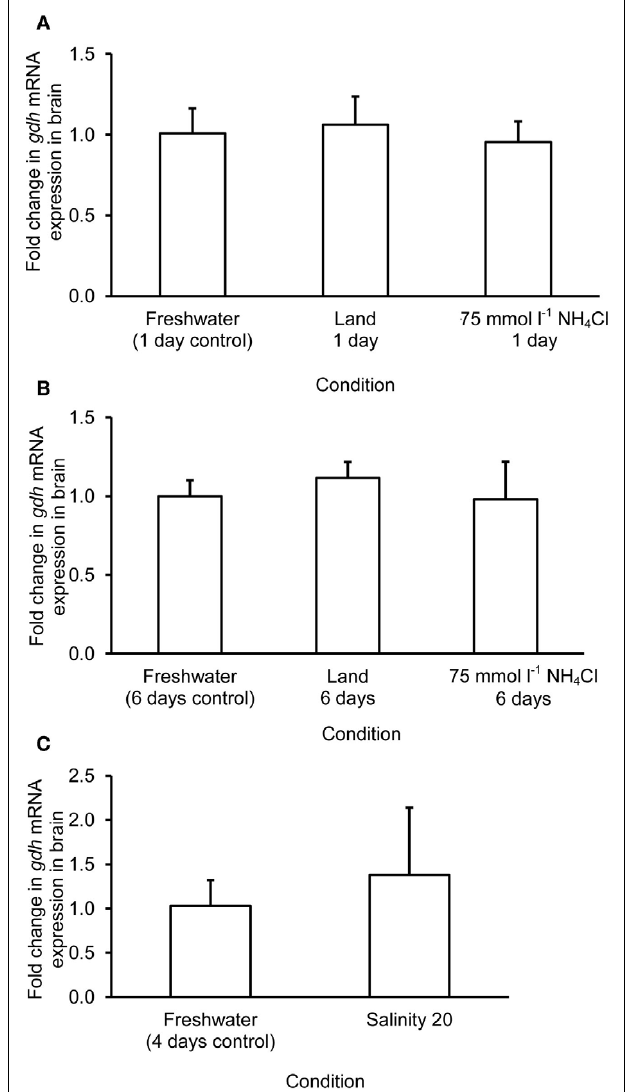
FIGURE 6 | Effects of (A) 1day of exposure to freshwater (control), terrestrial conditions, or 75mmoll − 1 NH 4 Cl, (B) 6days of exposure to freshwater (control), terrestrial conditions (land), or 75mmoll − 1 NH 4 Cl, and (C) 4days of exposure to freshwater (control) or 1day of exposure to salinity 20 after a 3-day progressive increase in salinity from freshwater on the mRNA expression (fold change) of glutamate dehydrogenase 1a ( gdh1a ) in the brain of Monopterus albus . Results represent mean + SD ( N = 4). Statistical analysis was applied after log 2 transformation of the individual fold change